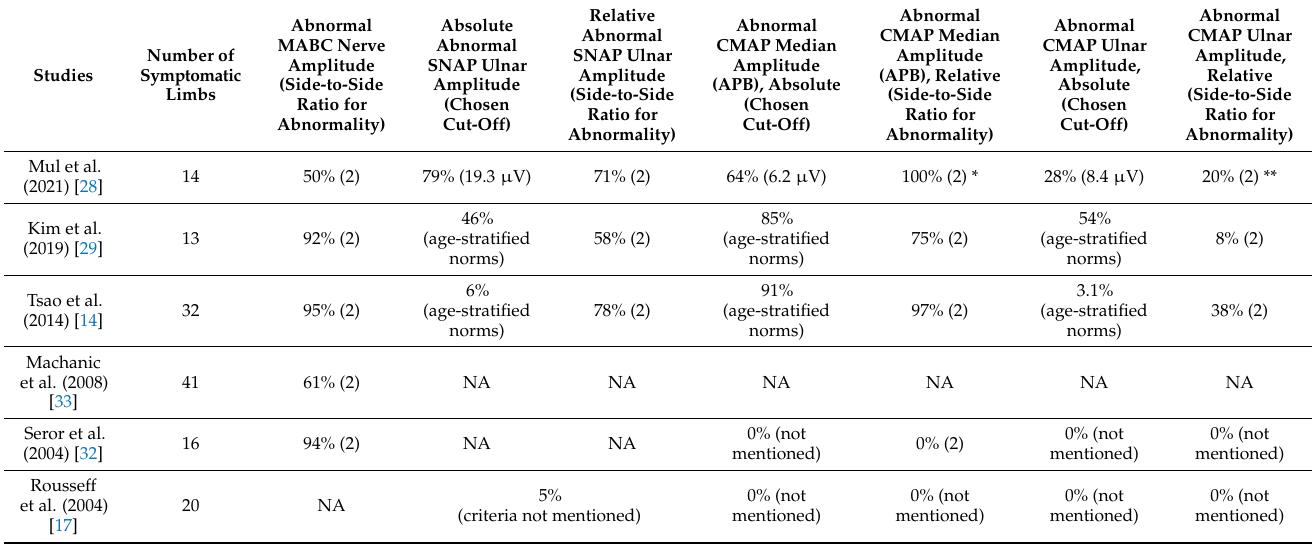
Table 3. Sensory and motor nerve conduction studies.